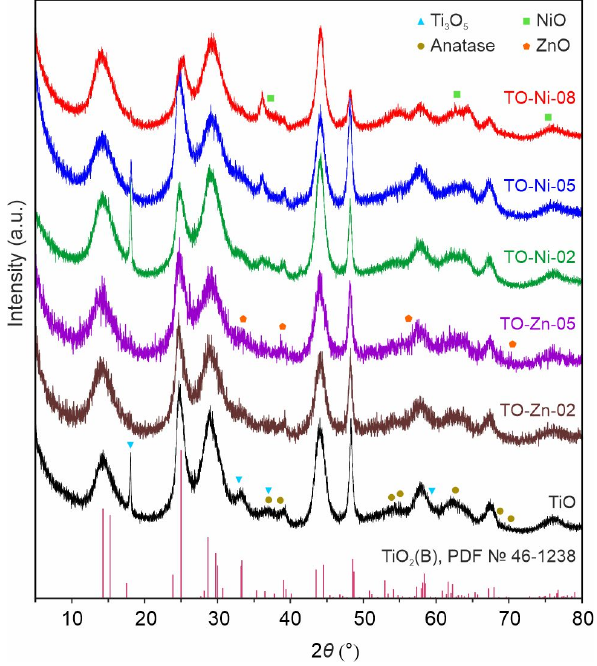
Figure 1. XRD patterns for as-synthesized samples doped with nickel and zinc TiO 2 (B).